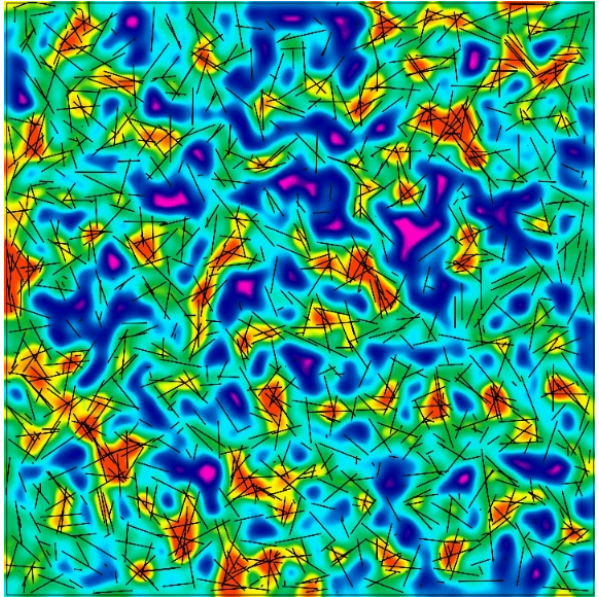
Figure 9. A computer simulation of fibre spacing exposing fibre concentration fields (warm colours) and low intensity of fibre appearance (cold colours).